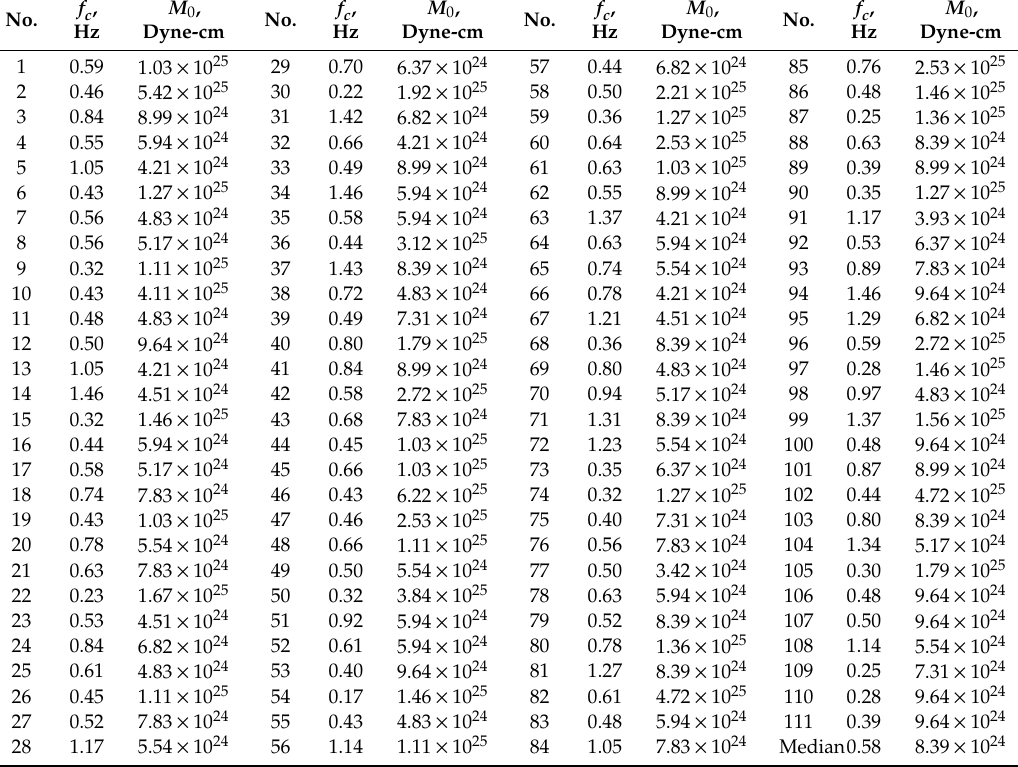
Table A2. Calculated corner frequency and seismic moment at all stations used in this